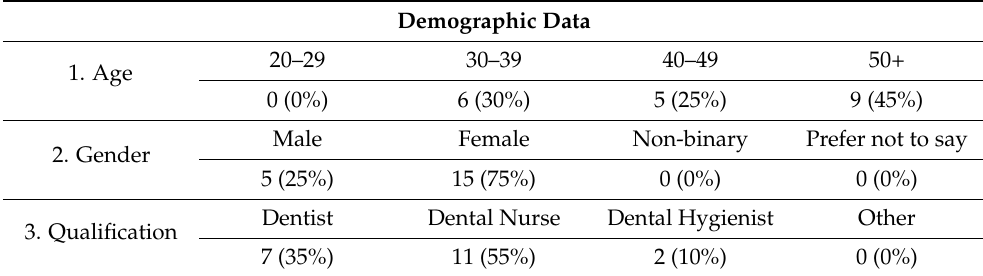
Table 1. Section 1 : Demographic Table 1. Section 1: Demographic data.